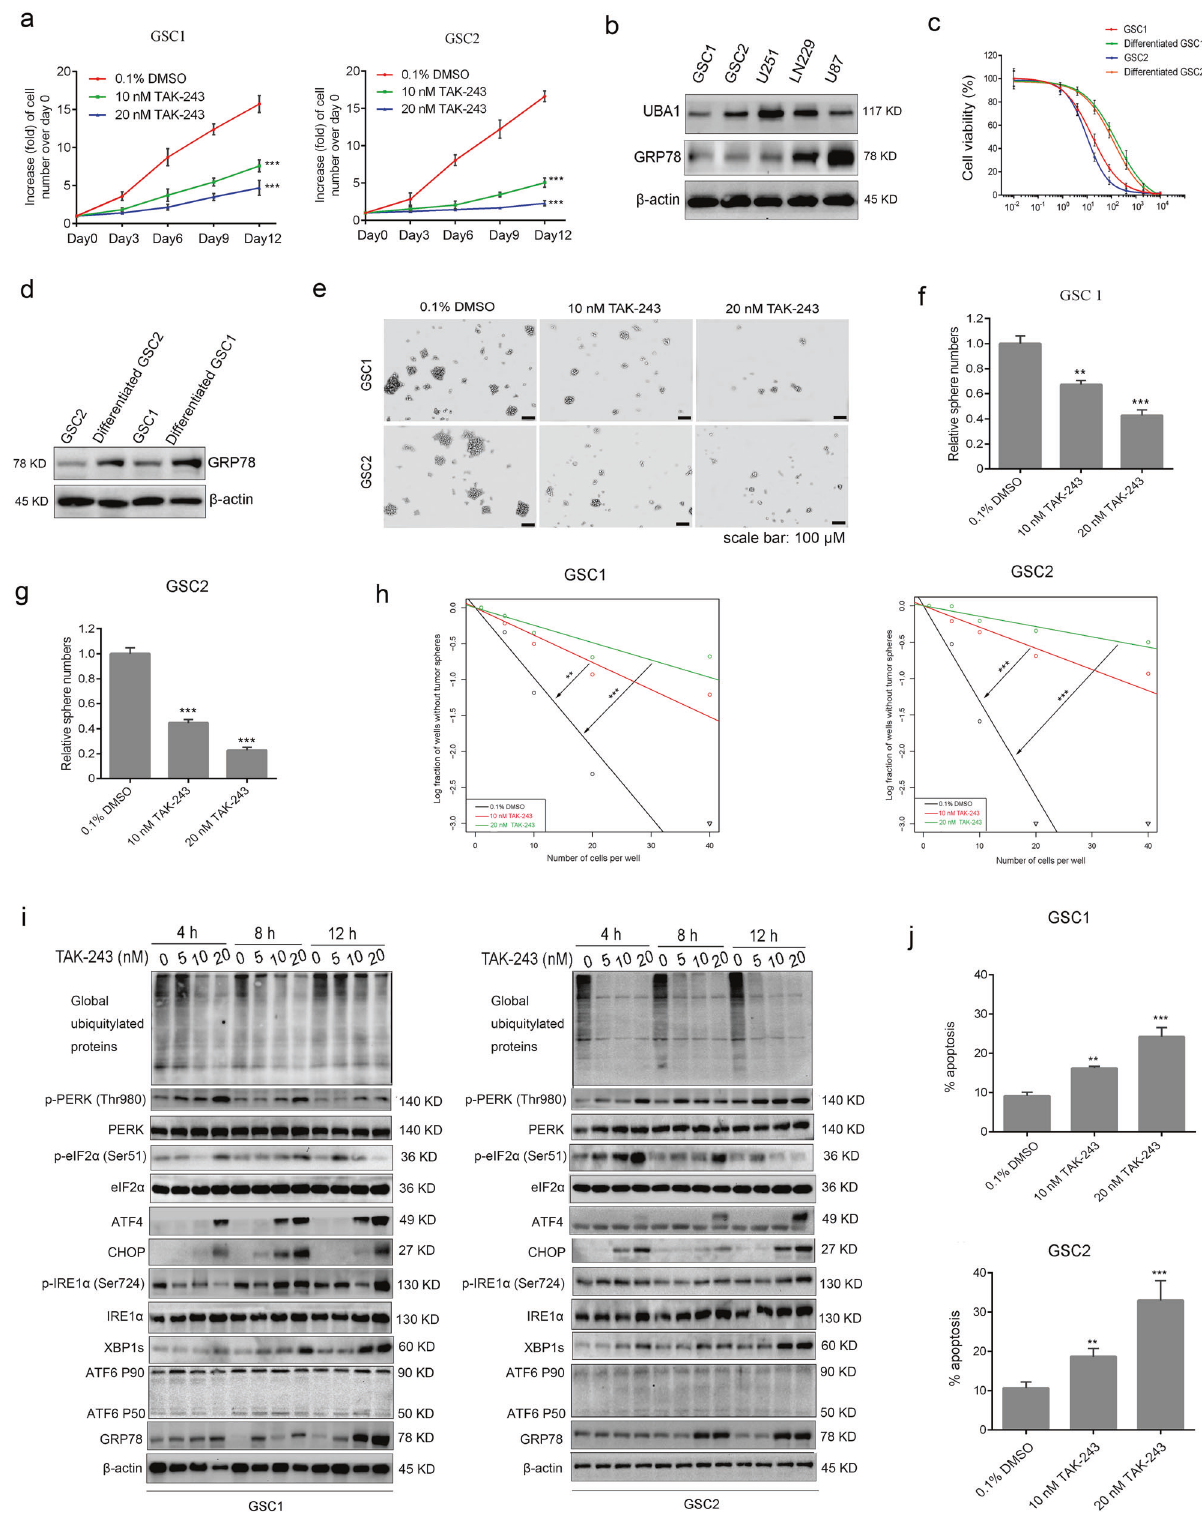
Fig. 6 TAK-243 disrupts GSCs proliferation and maintenance. a Effects of TAK-243 on cell viability in GSC1 and GSC2. b GRP78 and UBA1 expression levels were examined by immunoblotting in GSCs and GBM cells lines. c Cell viabilities were evaluated by CCK-8 assays in GSCs and differentiated GSCs. d Immunoblot analyses of GRP78 levels in GSCs and differentiated GSCs. e − g Effects of TAK-243 on GSCs neurosphere formation, scale bar: 100 μ m. h In vitro limiting dilution assays of GSC1 and GSC2 treated with indicated doses of TAK-243 or DMSO. i Representative western blot analysis showing dose-response and time course of the effects of TAK-243 on the polyubiquitylation and ER stress in GSC1 and GSC2, as assessed by immunoblotting for polyubiquitin (polyUb), GRP78, p-PERK(Thr980), PERK, p-eIF2 α , eIF2 α , ATF4, p-IRE1a (Ser724), IRE1a, CHOP, XBP1s, and ATF6. j The effects of TAK-243 on GSC1 and GSC2 apoptosis as evaluated by Annexin V/PI staining. All the Data are presented as means ± SD. ** P < 0.01, *** P < 0.001. Cell Death and Disease (2021)